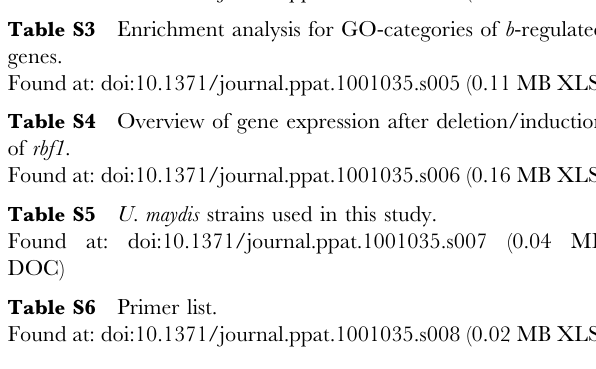
Table S6 Primer